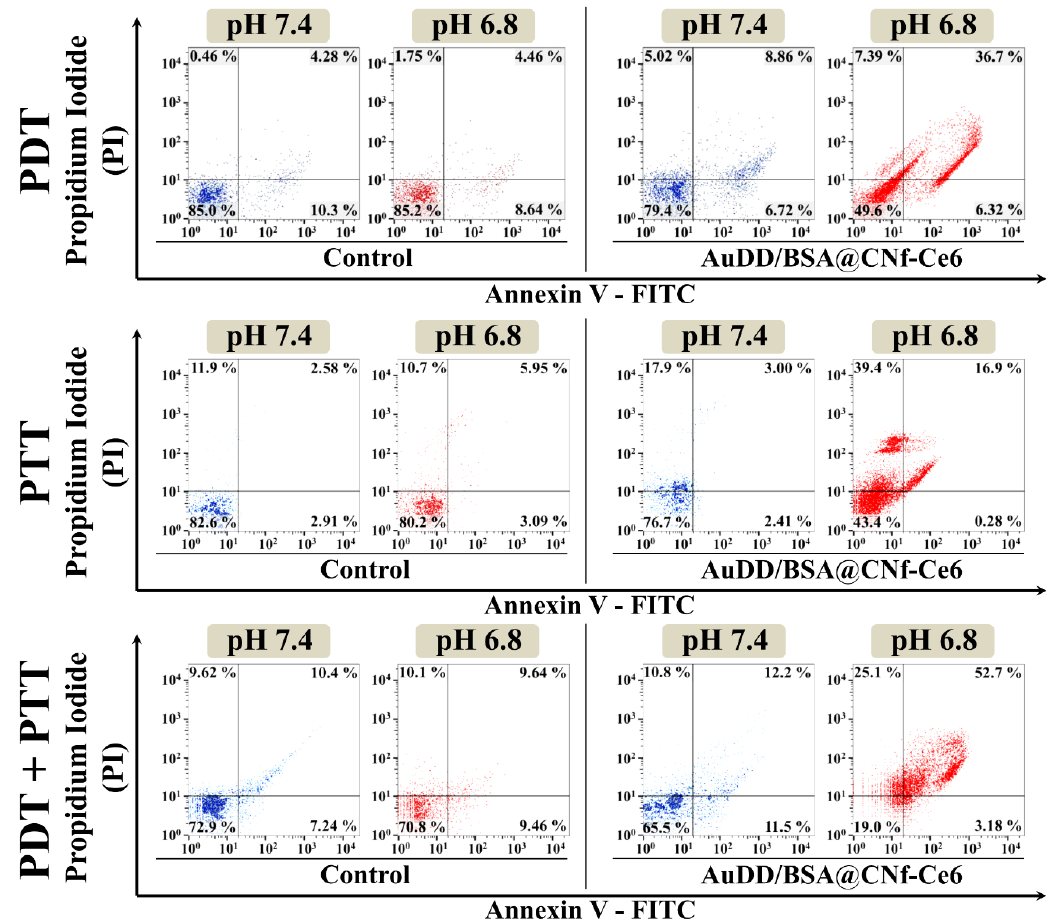
Figure 8. Flow cytometry results of apoptosis/necrosis using control (untreated)